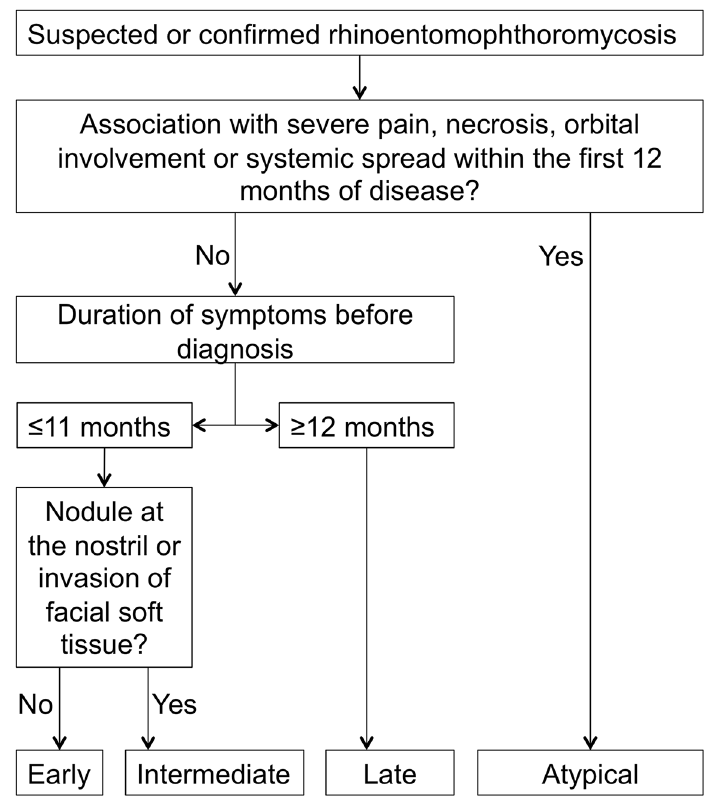
Fig 4. Algorithm for the staging of rhinoentomophthoromycosis. This algorithm is based on the clinical presentation of suspected/confirmed cases of rhinoentomophthoromycosis and the time since the onset of the first symptoms. The presence of a nodule at the nostril or invasion of facial tissue is the cornerstone to differentiate between early and intermediate